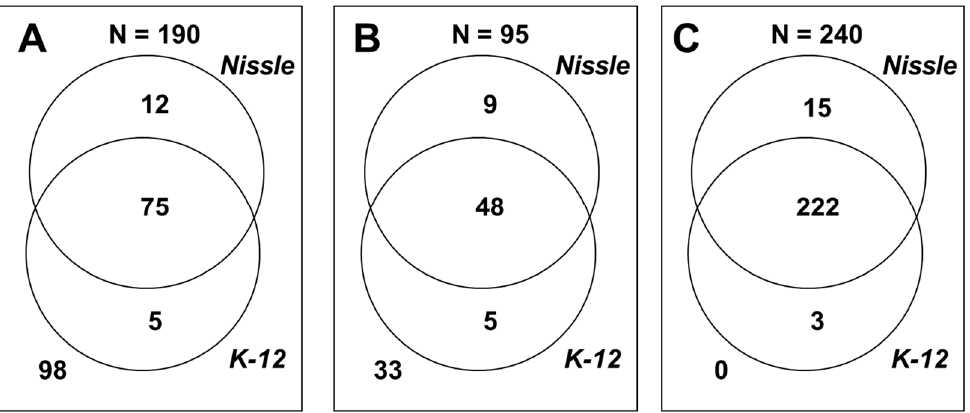
Figure 1. Comparison of phenotype microarray (PM) tests of E. coli strains Nissle 1917 and K-12 MG1655. ( A ) Carbon sources (PM1 and PM2). ( B ) Nitrogen sources (PM3). ( C ) Inhibitory compounds, such as antibiotics, antimetabolites, and other inhibitors (PM11 to PM20). The numbers indicate the number of nutrients on which cells grew.